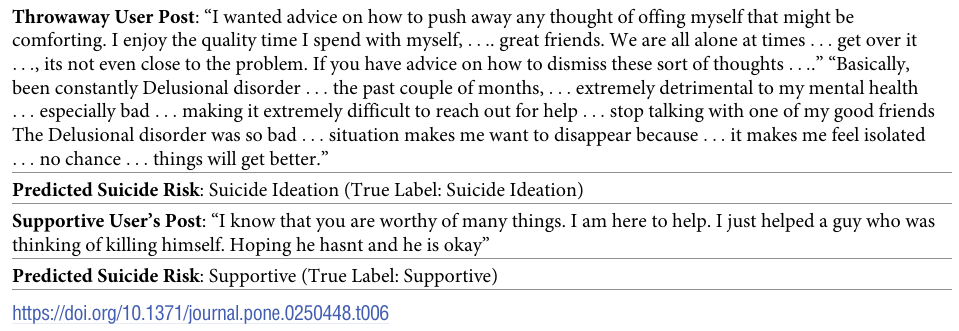
Table 6. Example informative posts published by throwaway accounts and supportive users on r/SuicideWatch. Throwaway User Post : “I wanted advice on how to push away any thought of offing myself that might be comforting. I enjoy the quality time I spend with myself, ... . great friends. We are all alone at times ... get over it ... , its not even close to the problem. If you have advice on how to dismiss these sort of thoughts ... .” “Basically, been constantly Delusional disorder ... the past couple of months, ... extremely detrimental to my mental health ... especially bad ... making it extremely difficult to reach out for help ... stop talking with one of my good friends The Delusional disorder was so bad ... situation makes me want to disappear because ... it makes me feel isolated ... no chance ... things will get better.” Predicted Suicide Risk : Suicide Ideation (True Label: Suicide